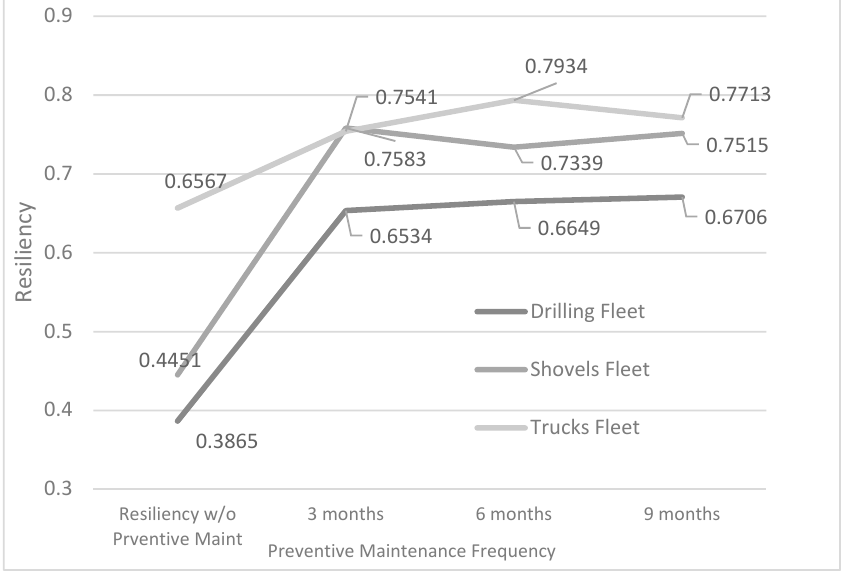
Figure 11. Resilience indexes of each sub-fleet with preventive maintenance in critical equipment.